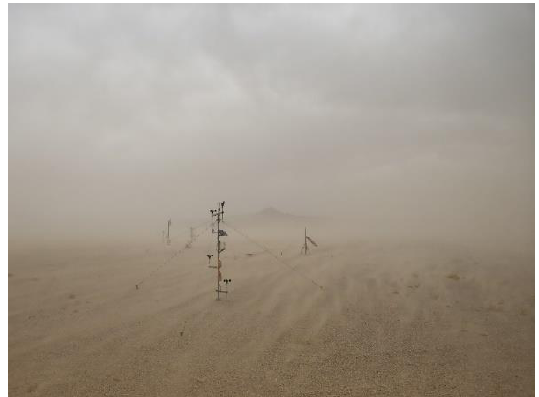
Figure 1. Location map and different aeolian landforms on top of the Mogao Grottoes (from Google Earth).